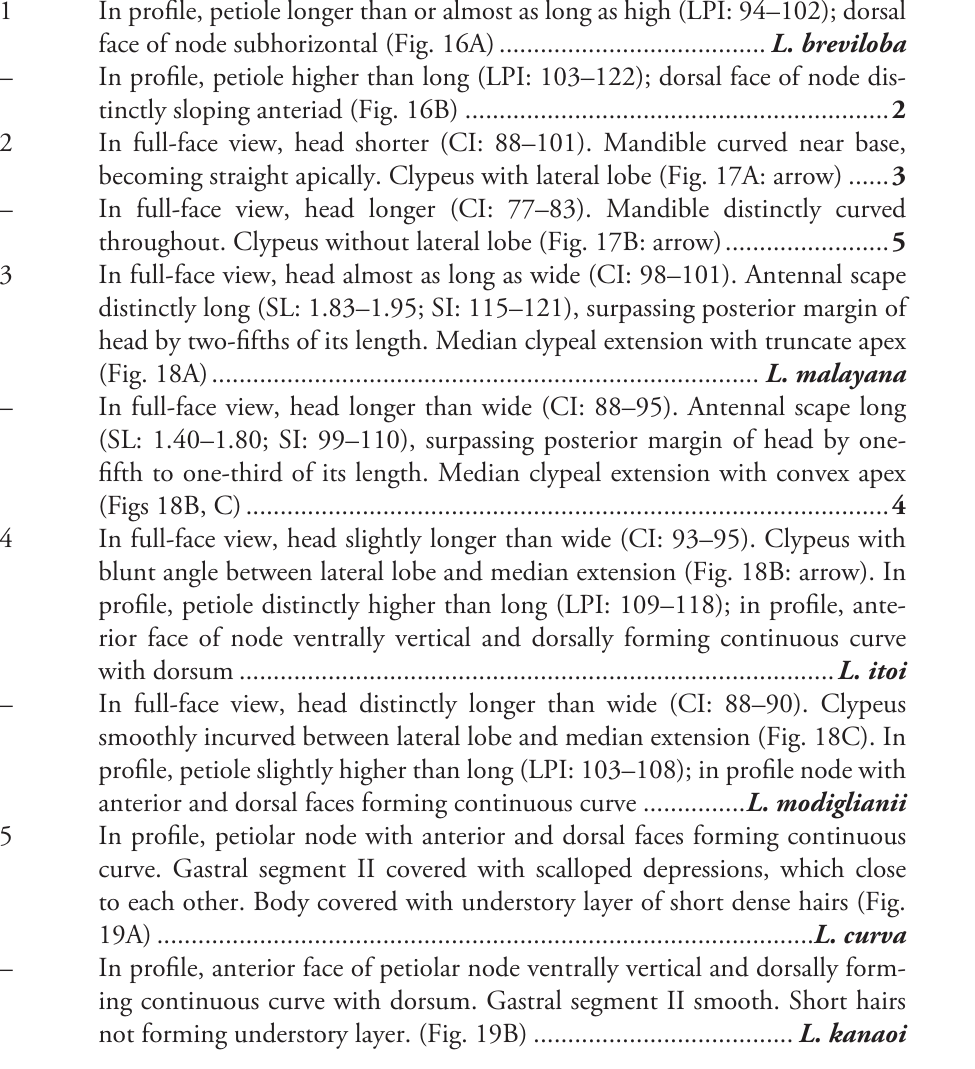
Key to species in the Leptogenys modiglianii species group from southeast Asia: worker In profile, petiole longer than or almost as long as high (LPI: 94–102); dorsal